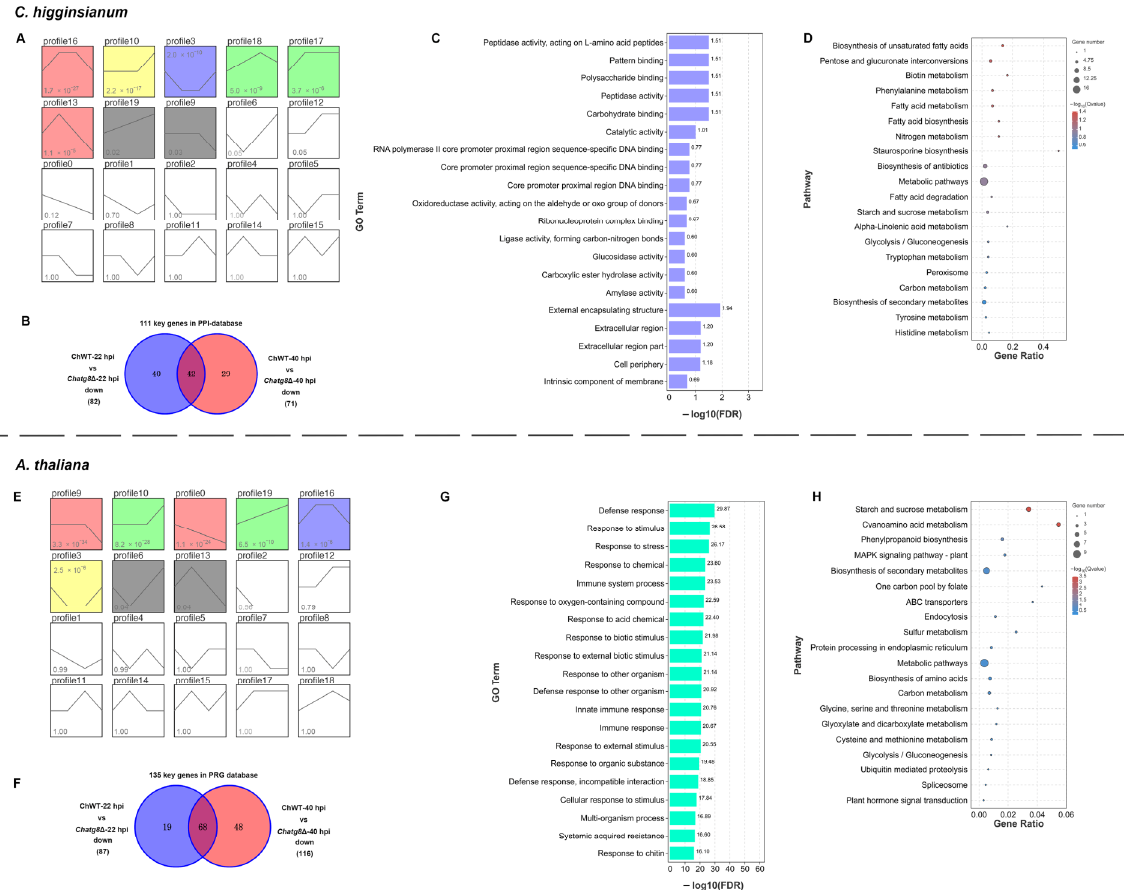
Figure 5. Key genes from C. higginsianum were annotated via PHI-base and key genes from A. thaliana were annotated via PRGdb. In C. higginsianum : ( A ) the 3402 key genes in C. higginsianum annotated by PHI-base were analyzed for expression profiles in the order of ChWT-8 hpi, ChWT-22 hpi, ChWT-40 hpi, and ChWT-60 hpi. A total of 1018 genes were significantly enriched in one of the four infection stages with up-regulated expression in profiles 16, 10, 18, 17, 13, and 19. ( B ) Venn diagram showing that 111 of the 1018 key genes were significantly down-regulated in the ChWT-22 hpi vs. Chatg8 Δ-22 hpi or ChWT-40 hpi vs. Chatg8 Δ-40 hpi comparison groups. ( C ) GO function and ( D ) KEGG pathway classification of the 111 DEGs. In A. thaliana : ( E ) the 2639 key genes in A. thaliana annotated by PRGdb were analyzed for expression profiles in the order of ChWT-8 hpi, ChWT-22 hpi, ChWT-40 hpi, and ChWT-60 hpi. A total of 497 genes were significantly enriched in